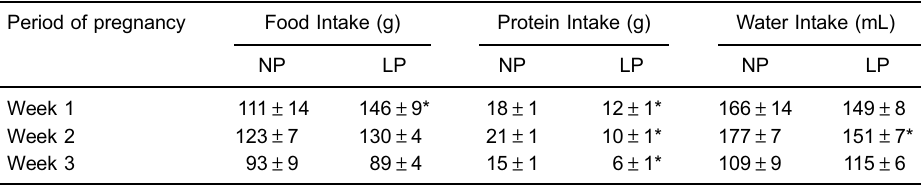
Table 2. Consumption of female rats submitted to a normal- (NP group, 17% protein) or low-protein diet (LP group, 8% protein) during pregnancy. Period of pregnancy